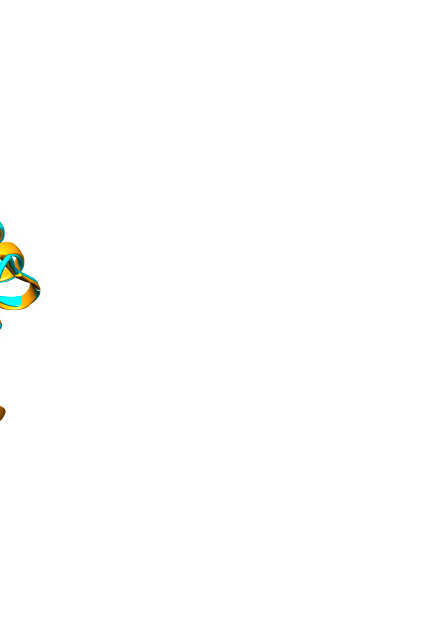
Figure 5. Superimposed structures of CHT (blue) and Nit6803 (golden) three-dimensional (3D)